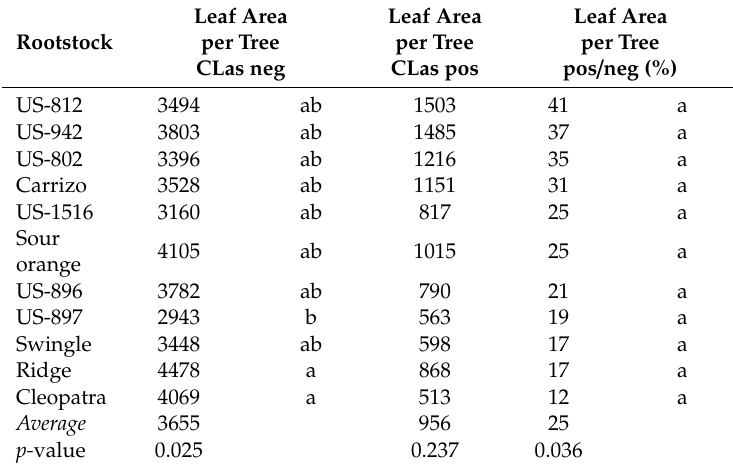
Table 8. Leaf area (cm 2 ) per tree at 50 wai.